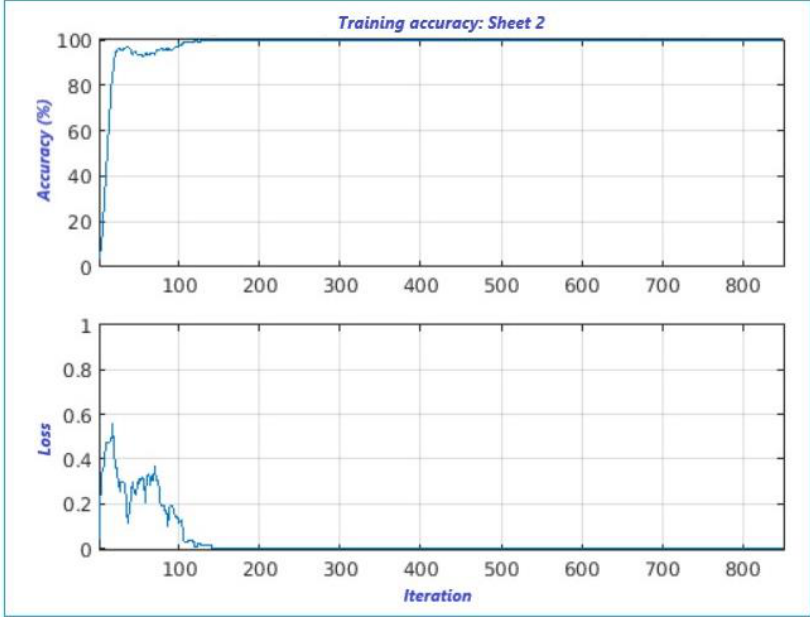
Figure 9. Proposed supervised leaning classification algorithm for sheet 2.